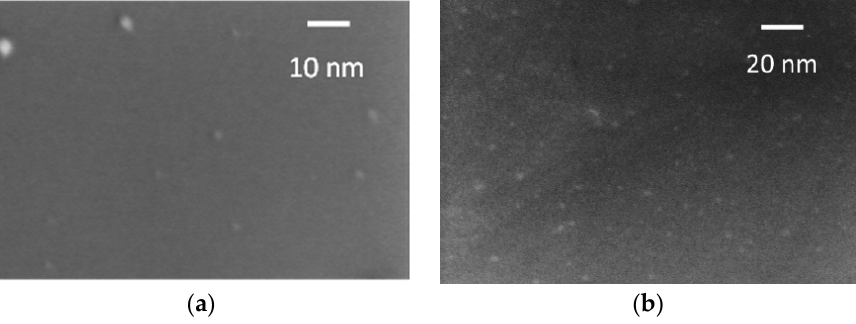
Figure 2. ( a ) SEM image of the N-CDs-W sample; ( b ) SEM image of the N-CDs-W-THF sample.